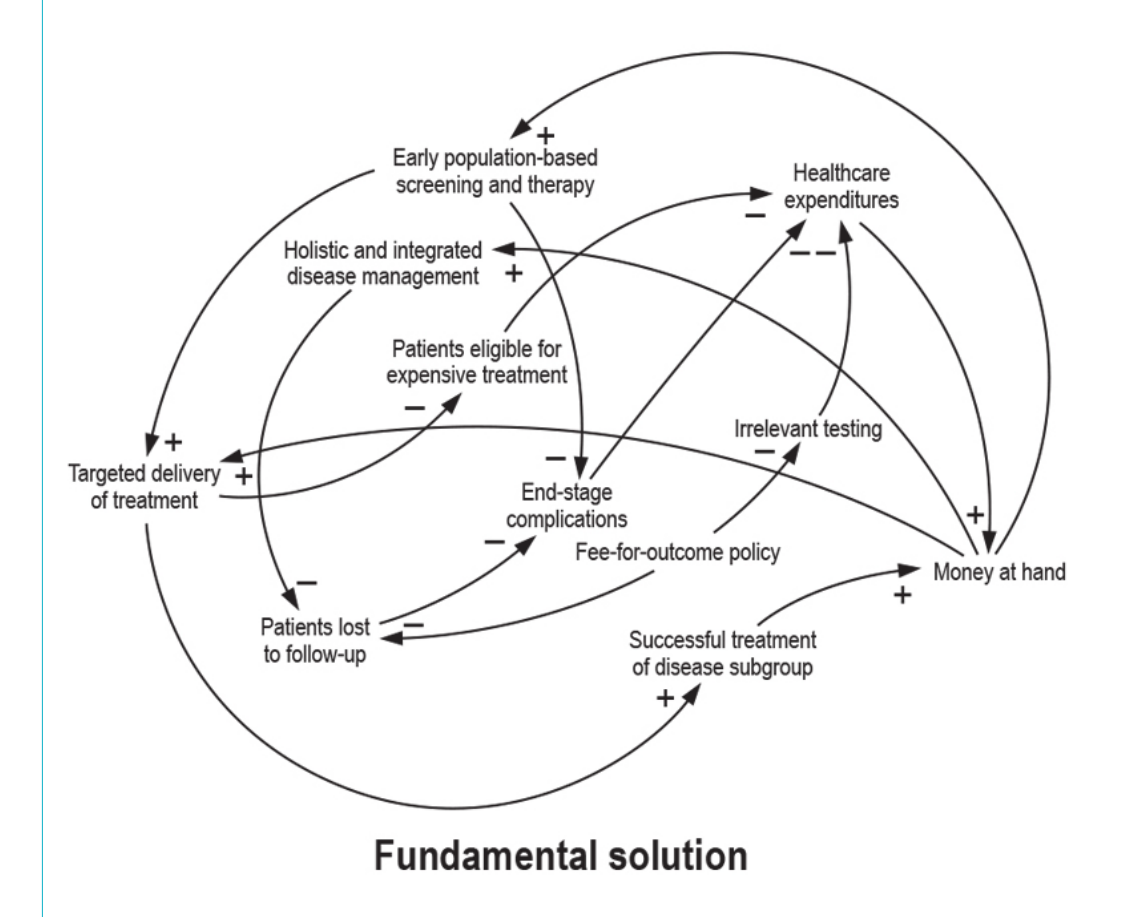
Figure 3: How interventions affect the current use of in vitro diagnostics.+ = amplifying feedback; – = attenuating